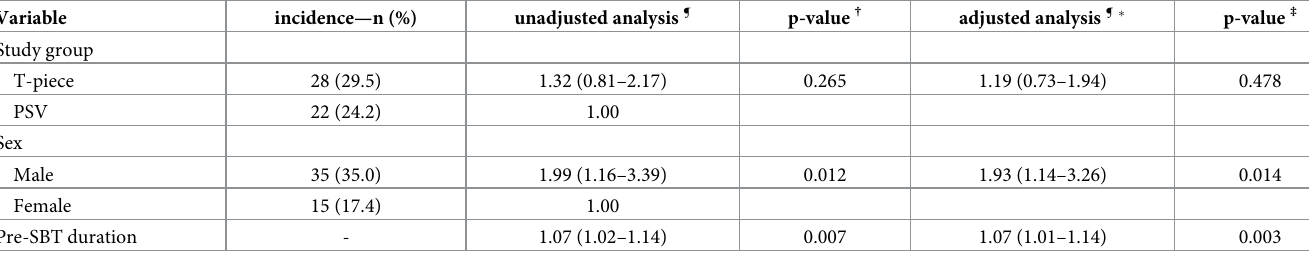
Table 6. Poisson models for 48-hour failure rate